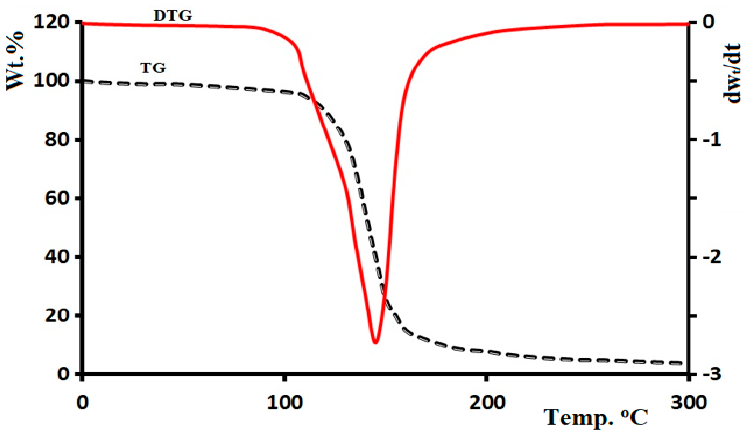
Figure 13. Thermogravimetric–derivative thermogravimetric (TG / DTG) curves of 2,5- dimethoxybenzaldehyde.